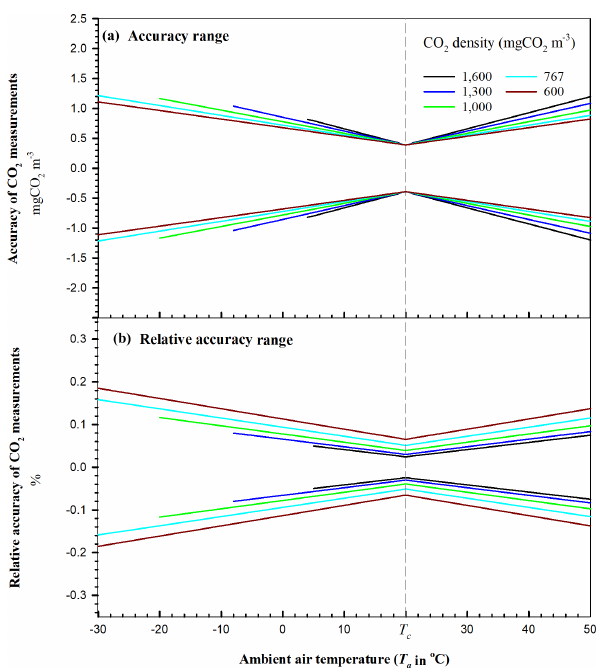
Figure 2. Accuracy of field CO 2 measurements from open-path eddy-covariance flux systems by EC150 infrared CO 2 –H 2 O ana- lyzers (Campbell Scientific Inc., UT, USA) over their operational range in T a at atmospheric pressure of 101.325kPa. The vertical dashed line represents ambient air temperature T c at which an ana- lyzer was calibrated, zeroed, and/or spanned. Above 5 ◦ C, accuracy is evaluated up to the possible maximum CO 2 density in ecosystems (black curves). Assume that this maximum CO 2 density starts lin- early decreasing at 5 ◦ C to the atmospheric CO 2 background value 767mgCO 2 m − 3 at − 30 ◦ C. Accordingly, below 5 ◦ C, the accuracy for CO 2 density at a level above the background value (green, blue, or black curves) is evaluated up to this decreasing trend of CO 2 den- sities. Relative accuracy of CO 2 measurements is the ratio of CO 2 accuracy to CO 2